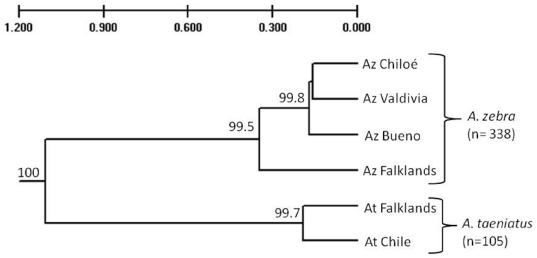
UPGMA clustering of A. zebra and A. taeniatus based on microsatellite markers using Nei's original distance [46].Numbers at each branch node represent % bootstrap support derived from 1,000 replicates.